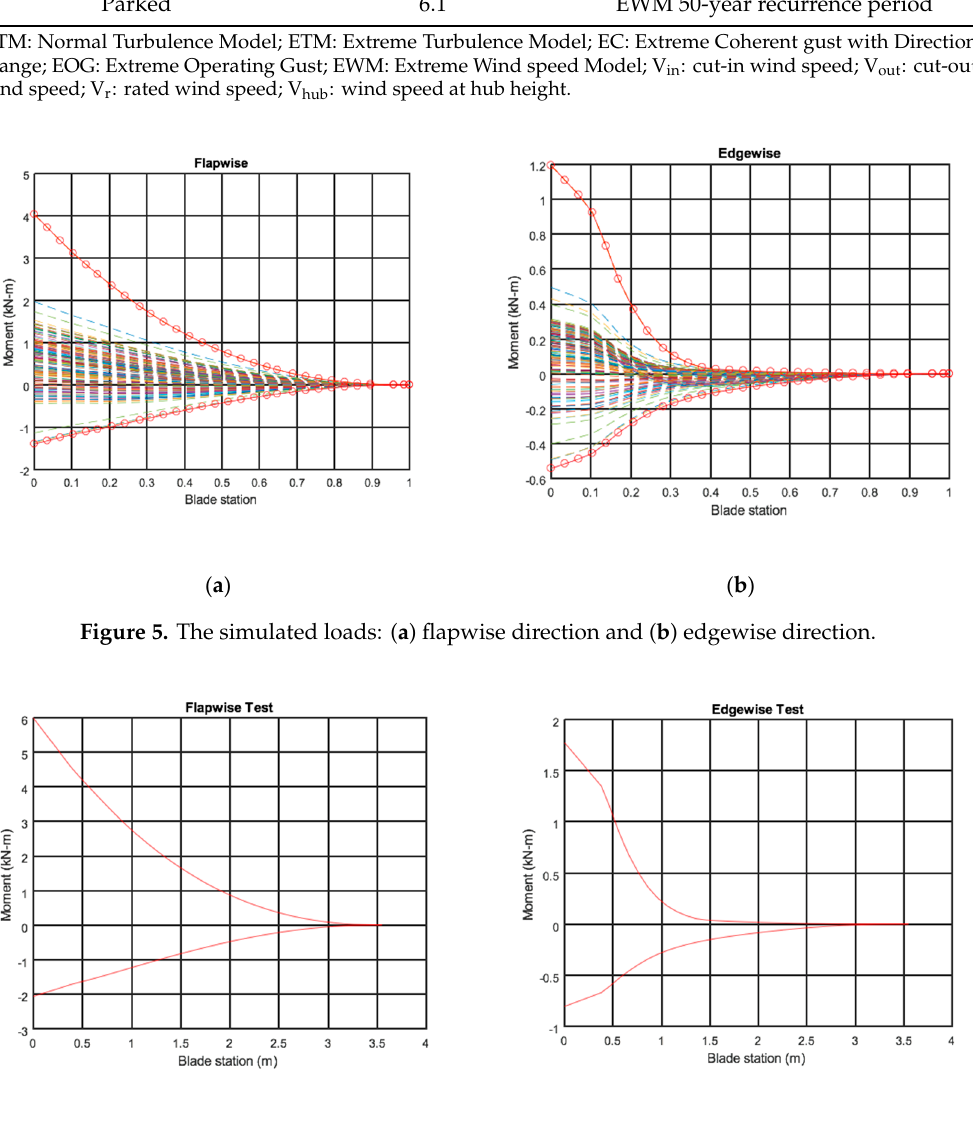
Table 2. Design load cases.